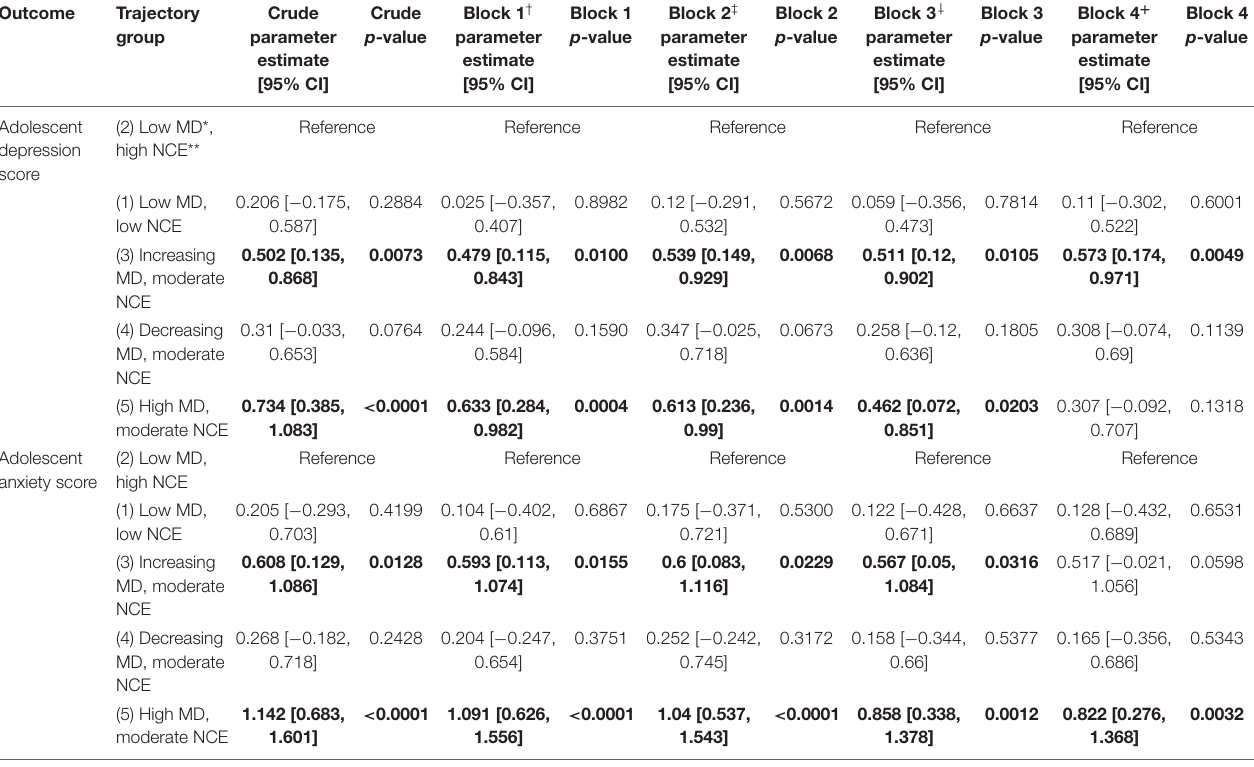
TABLE 3 | Results from adjusted models using trajectory group to predict adolescent mental health outcomes. Outcome Trajectory